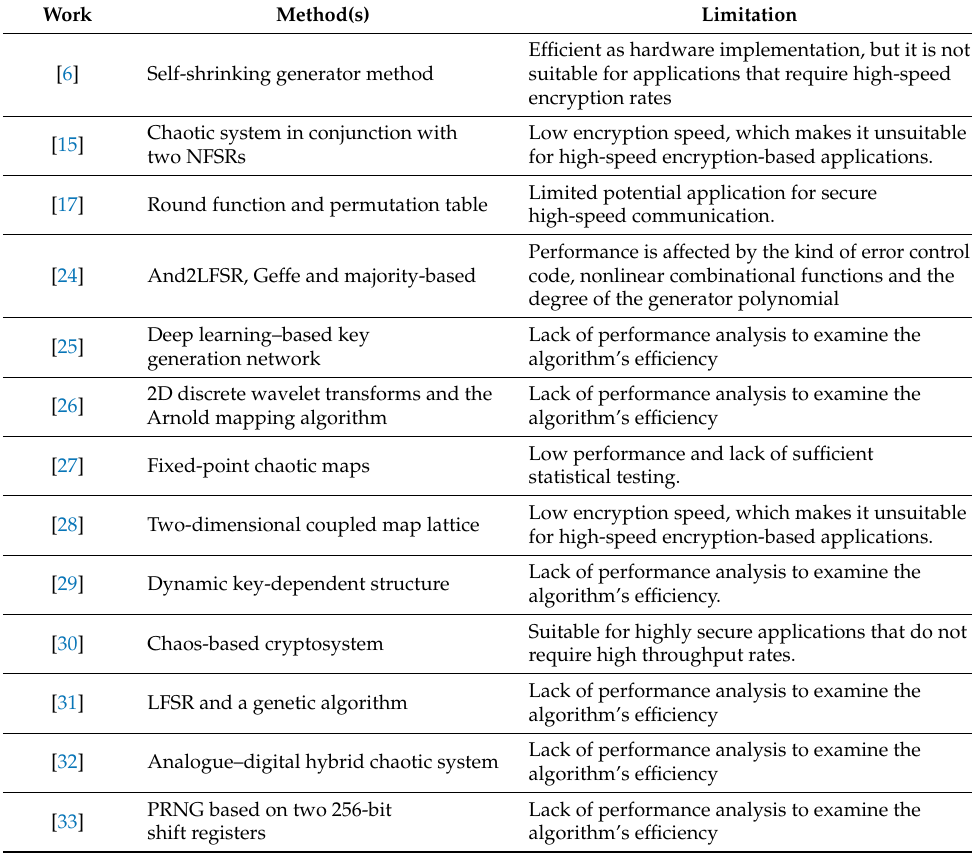
Table 2. Comparison of related